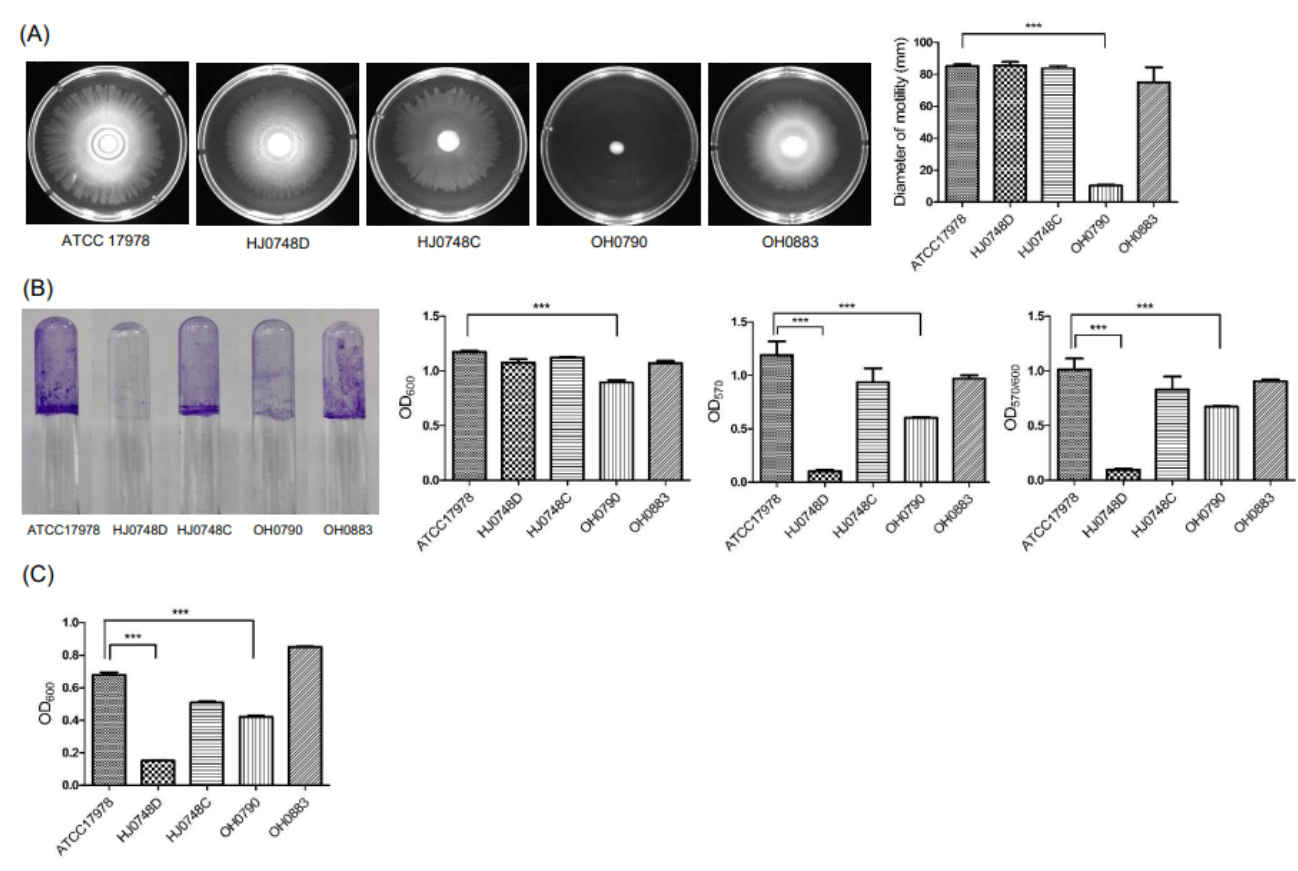
Figure 2. Surface motility, biofilm formation, and pellicle formation of Δ b fmR and Δ b fmS mutant strains. ( A ) A. baumannii ATCC 17,978 (wild-type), HJ0748D ( Δ bfmR mutant), HJ0748C ( bfmR -complemented strain), OH0790 ( Δ bfmS mutant), and OH0883 ( bfmS -complemented strain) were inoculated onto the center of motility agar plates and incubated for 12 h at 30 °C. Bacterial migration on the agar plates was measured. The surface motility assay was performed in three independent experiments. ( B ) A. baumannii strains were grown in MH medium for 48 h at 30 °C under static conditions. Biofilms were stained with crystal violet. The amount of crystal violet eluted from the biofilms was quantified by measuring the OD 570 . Biofilms were normalized to the total bacterial growth (OD 600 ). The data are presented as the mean ± SEM of three independent experiments. ( C ) A. baumannii strains were grown in MH medium for 72 h at 30 °C under static conditions. Pellicles were quantitated by measuring the OD 600 . The data are presented as the mean ± SEM of three independent experiments. *** p < 0.001 compared to the WT strain.